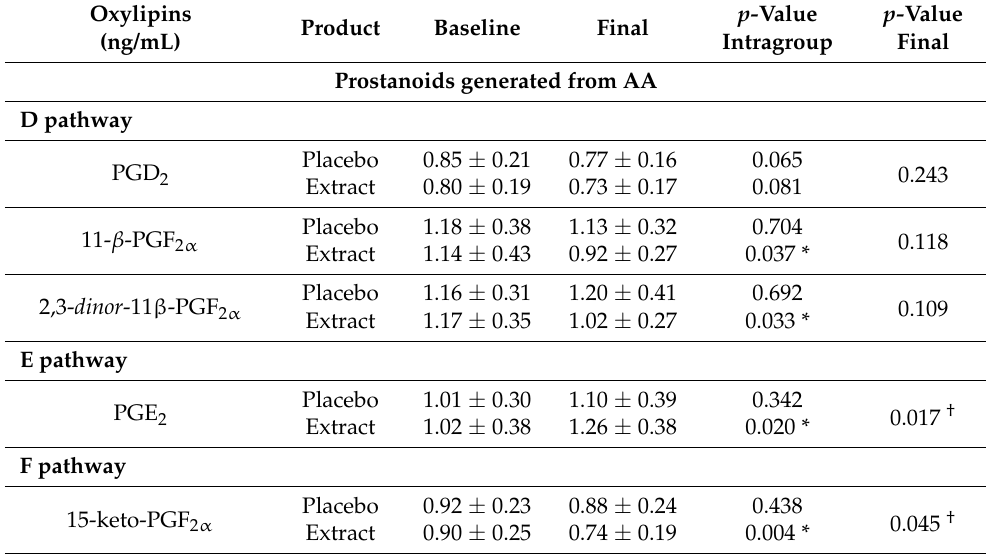
Table 3. Evolution of the different isoprostanes measured during the study. Values are expressed as mean and standard deviation at the beginning and end of the